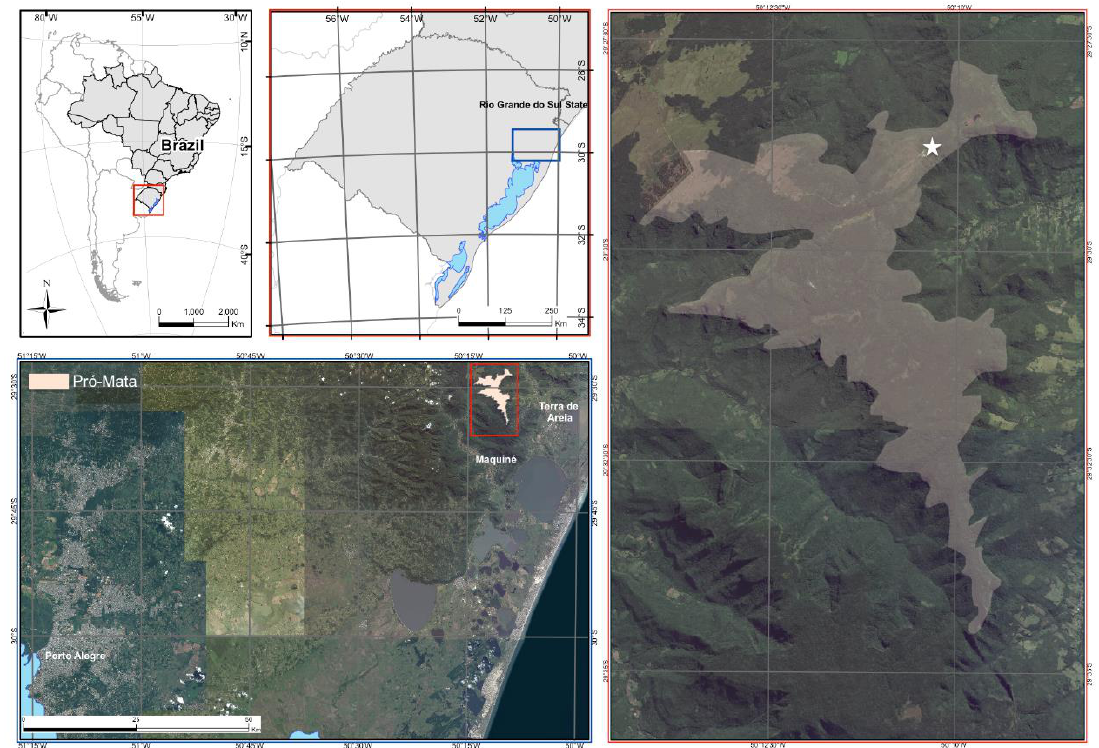
Figure 1. Sampling site (white star) at the Center for Research and Nature Conservation Pró-Mata, northeastern Rio Grande do Sul state, southernmost Brazil.